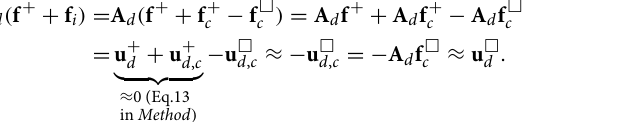
Figure 5. Active cloaking of the electric self-potential u (cid:31) density f . Using Eq. (13) the cloaking devise is modelled by the current source density f (cid:31) generates u d , c ( c ) leading to a significant reduction (almost cancellation) of the electric potential signal on Ŵ ( d ). Panel ( e ) demonstrates the cancellation of the signal u { x ∈ (cid:31) a : x 1 = 0 km ; x 3 = 0.5 km } ⊂ Ŵ